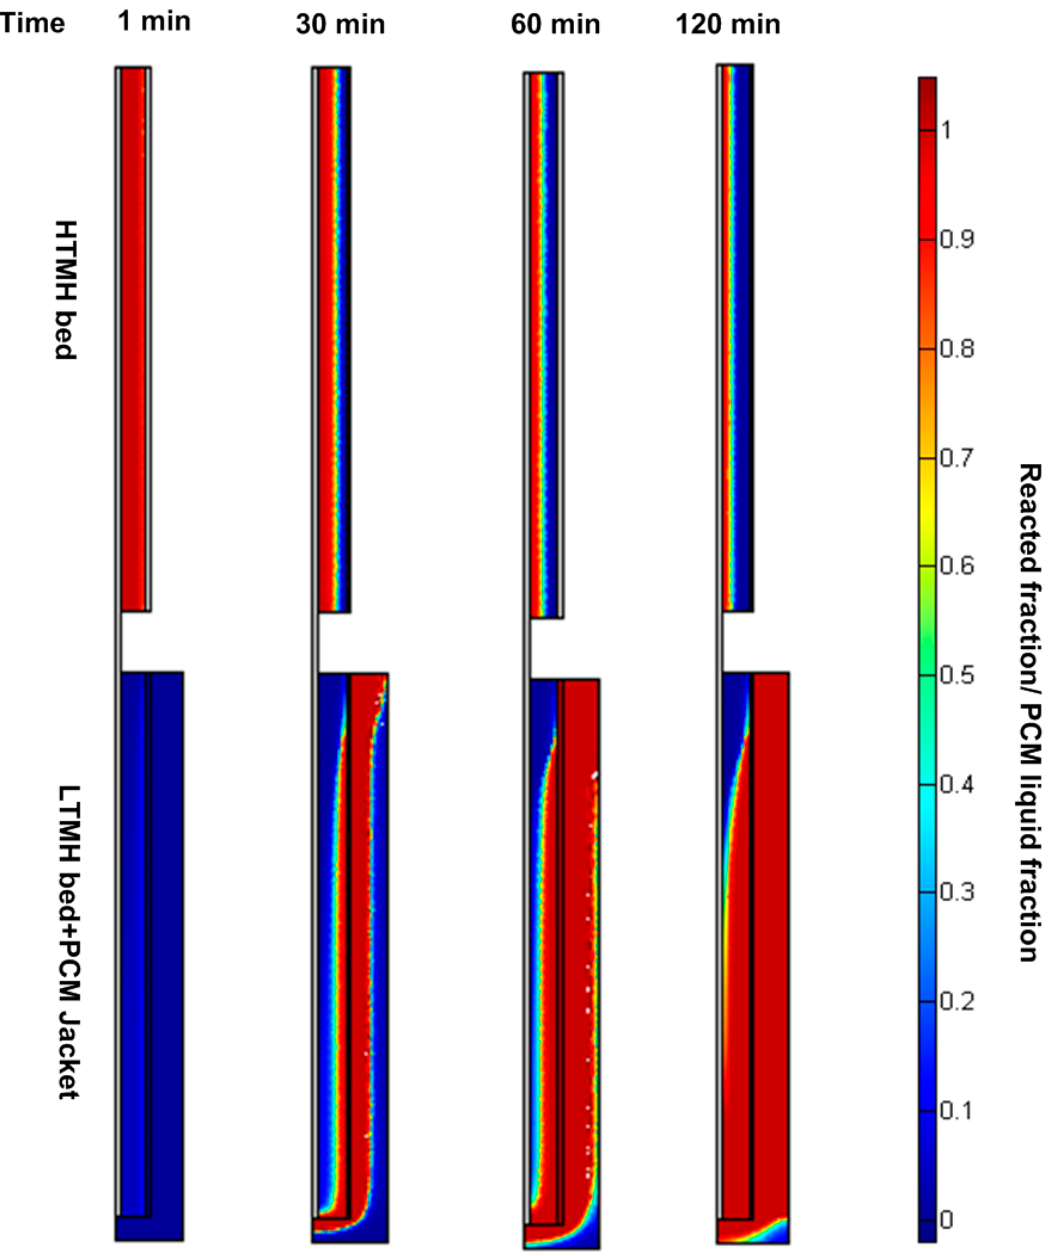
Figure 10. H 2 reacted fraction/PCM liquid fraction spatial distribution in the control volume at selected time (1, 30, 60 and 120 min) during the heat charging.